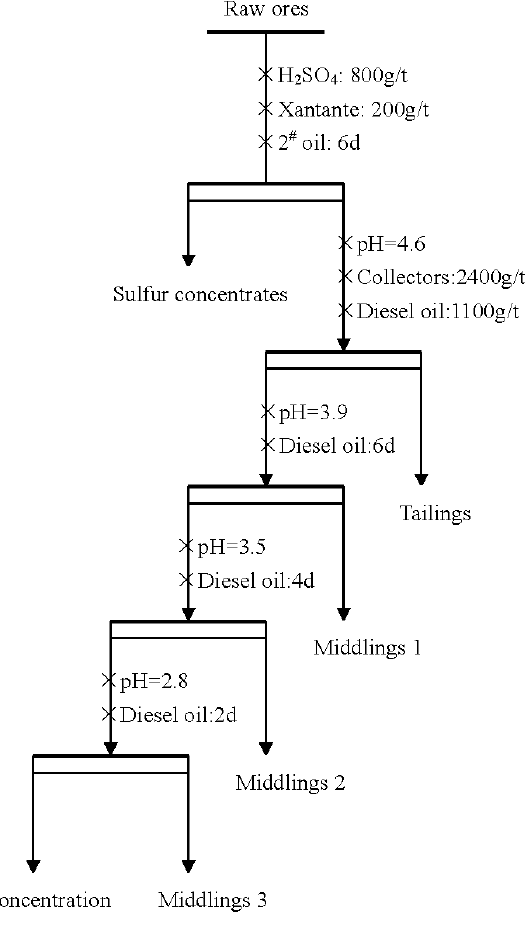
Figure 2. Principal flowchart for the ilmenite flotation experiments (H 2 SO 4 was used as pH